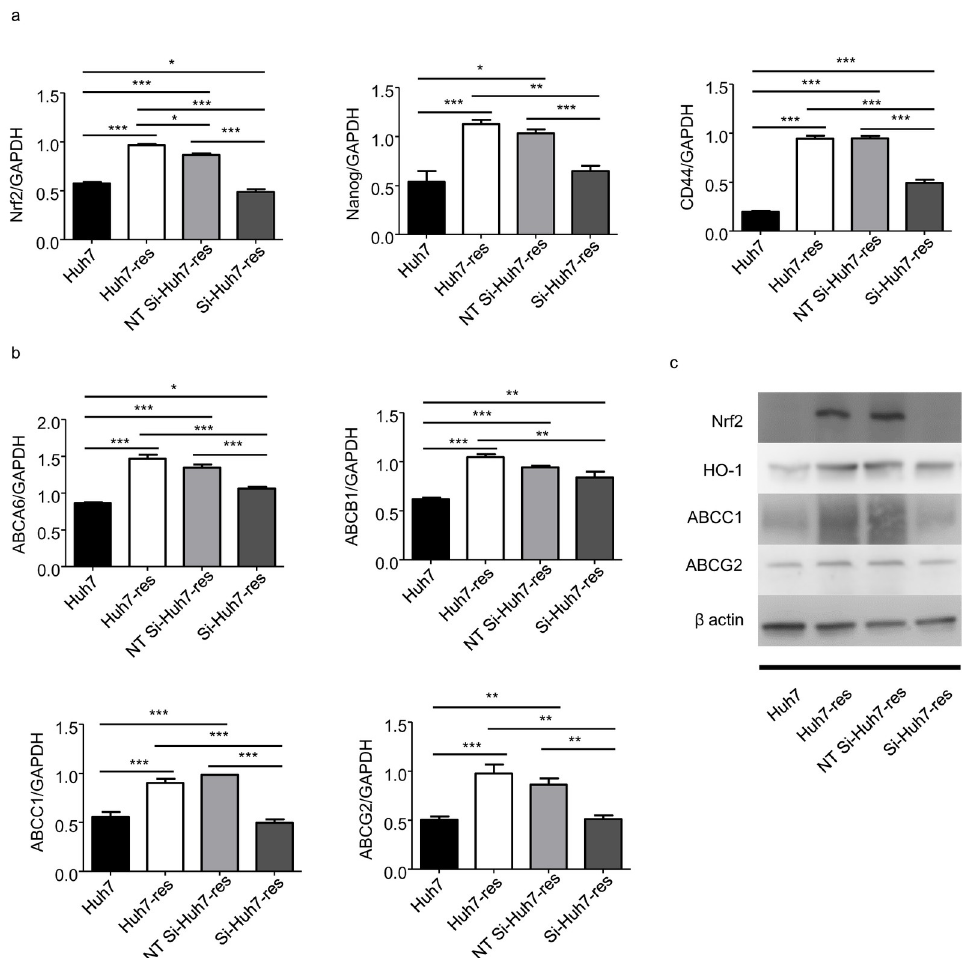
Fig 5. Decreased expression of Nrf2 related genes and stemness markers in Nrf2 knocked down resistant Huh7 cells treated with siRNA. a. PCR quantification of Nrf2, CD44, Nanog mRNA expressed in Nrf2 knocked down resistant Huh7 cells compared with sorafenib-resistant Huh7 cells, non-targeting control si-RNA treated resistant cells (NT Si- Huh7-res) and normal Huh7 cells, expressed for 48h cultured in DMEM (10%FBS). (n = 4) � indicates P value < 0.05) �� indicates P value < 0.01) ��� indicates P value < 0.001. b. PCR quantification of ABC tranporters ABCA6, ABCB1, ABCC1, ABCG2 mRNA expressed in Nrf2 knocked down resistant Huh7 cells compared with sorafenib-resistant Huh7 cells, NT Si-Huh7-res cells and normal Huh7 cells, expressed for 48h cultured in DMEM (10%FBS). (n = 4) � indicates P value < 0.05) �� indicates P value < 0.01) ��� indicates P value < 0.001. c. Levels of Nrf2 related protein (Nrf2, HO-1) and ABC transporters (ABCC1, ABCG2) in Nrf2 knocked down resistant Huh7 cells compared with sorafenib-resistant Huh7 cells, NT Si-Huh7-res cells and normal Huh7 cells were analyzed by western blotting.